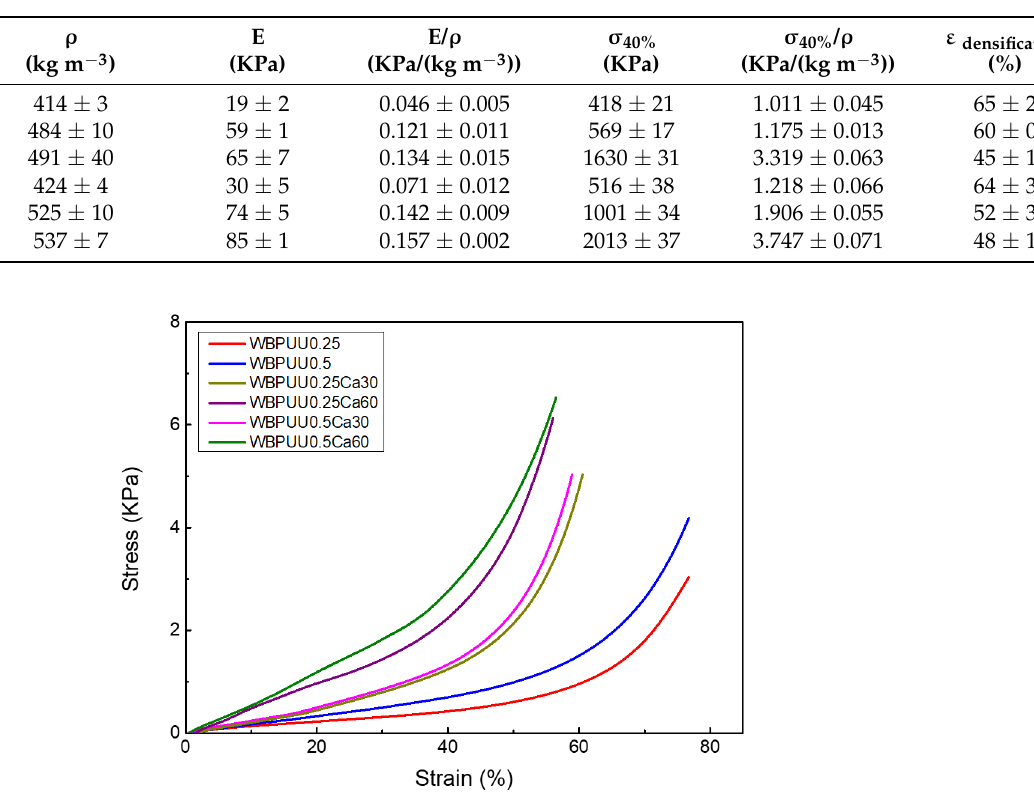
Table 4. Density, compression properties, and specific compression properties of the WBPUU/CNC prepared scaffolds.